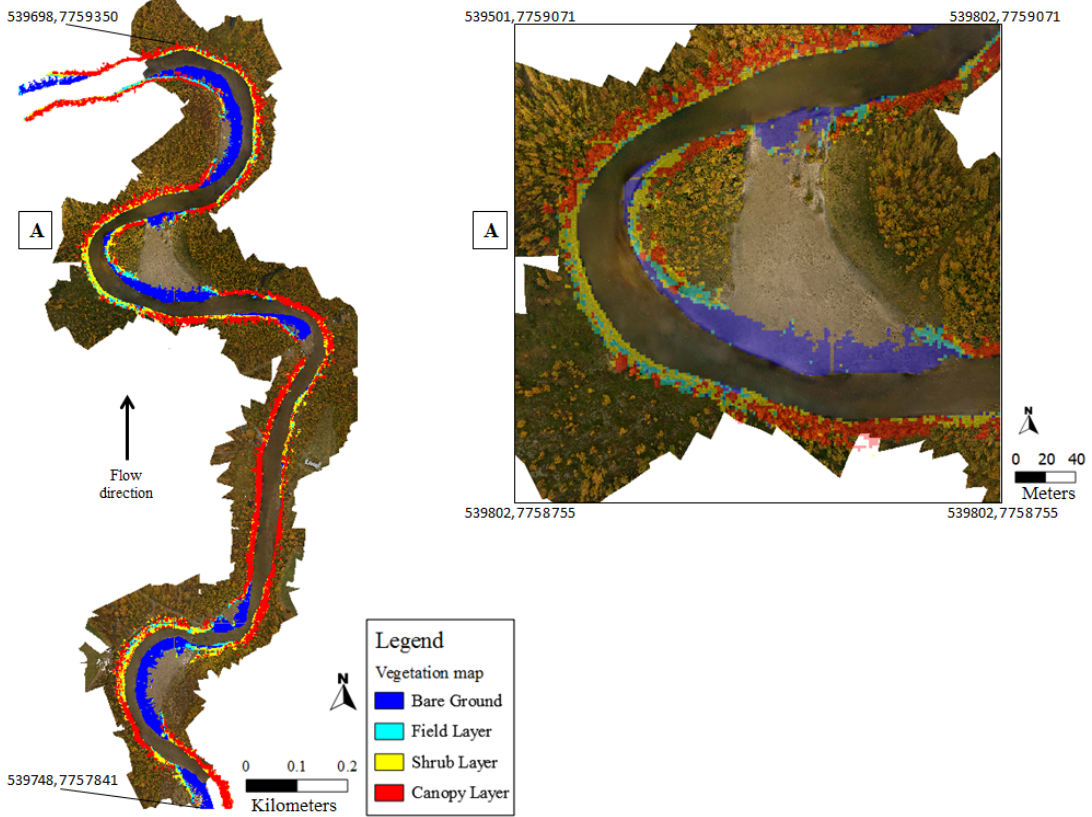
Figure 5. Vegetation estimations for the area covered by aerial images in 2012 ( left ) with close capture of the downstream section of area A ( right ). Coordinates of the captures are presented in ETRS89/ETRS-TM35FIN.